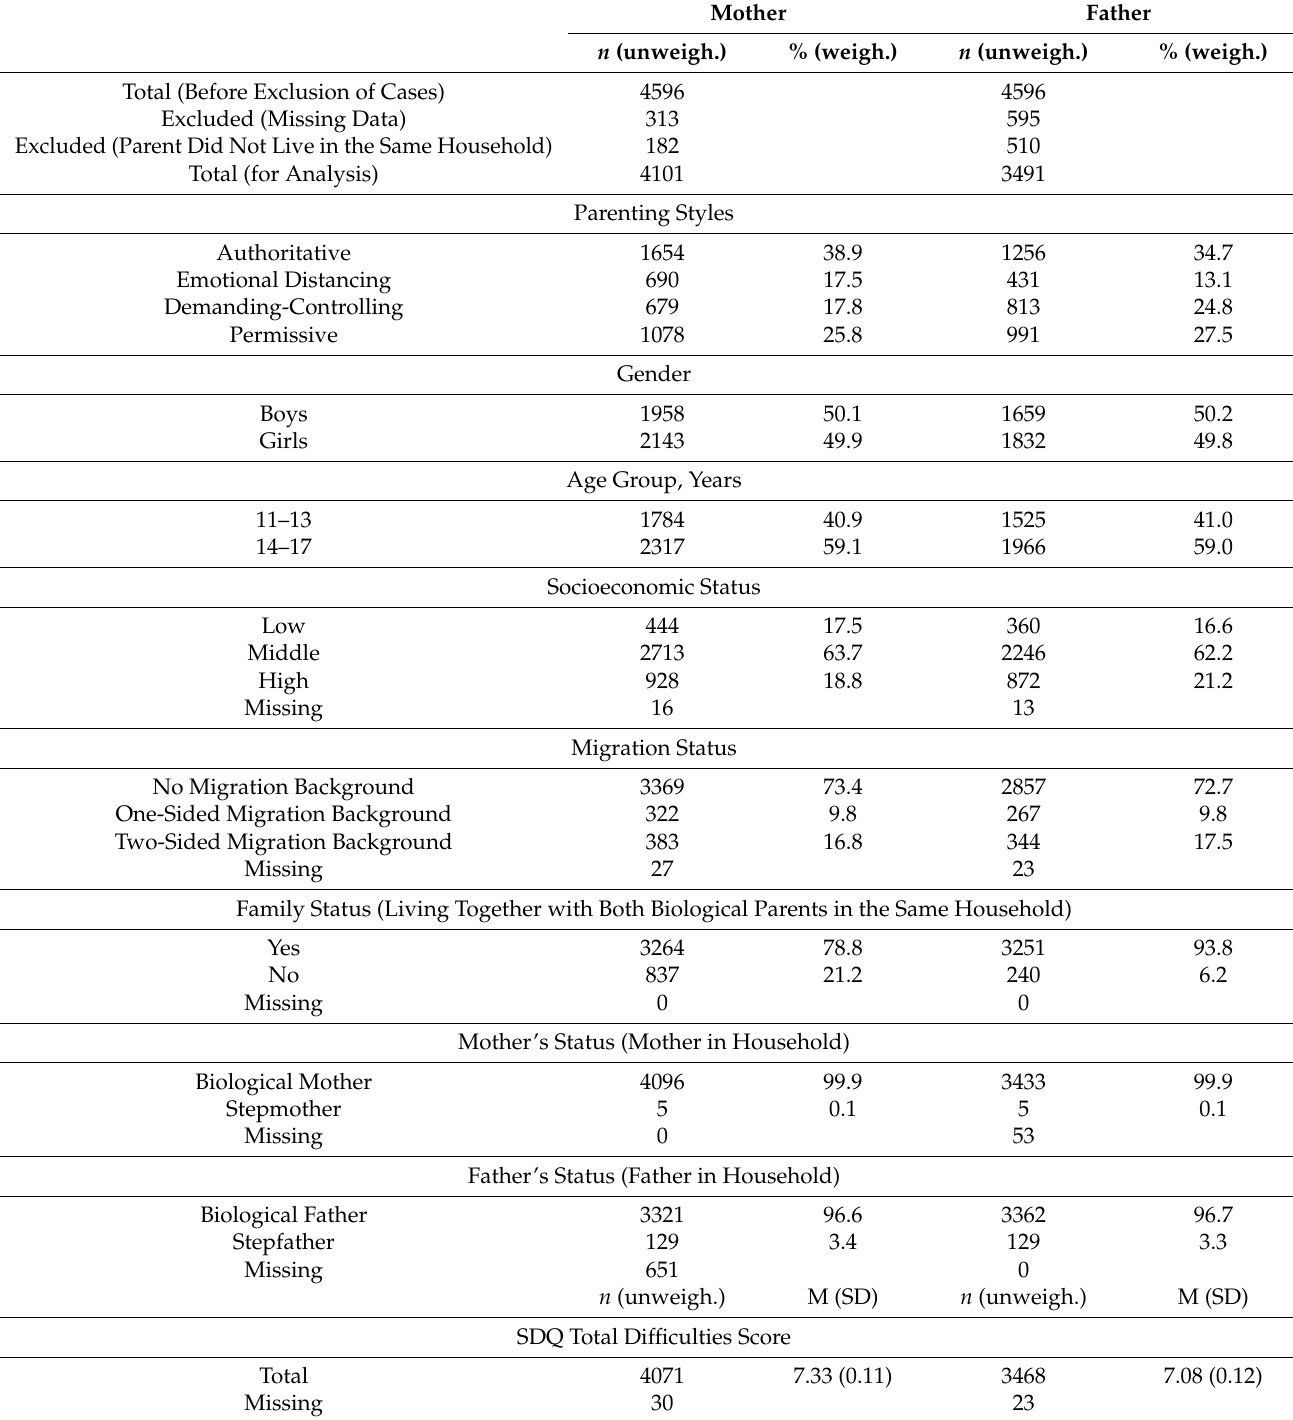
Table 1. Sample characteristics, by parenting style of mothers and